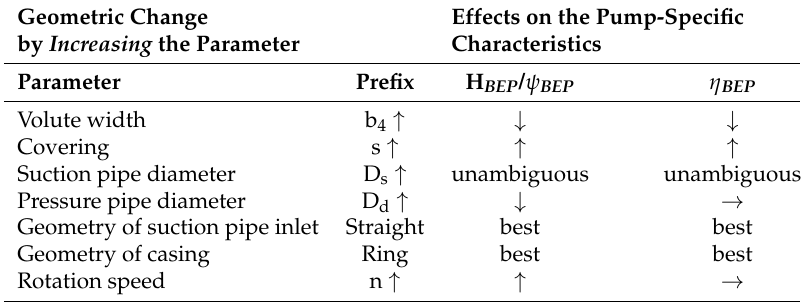
↓ ↓ ↓ ↓ ↑ ↑ ↑ Table 4. Geometric changes to the casing and changes to rotation speed and their effects on the pump-specific characteristics. Effects on the Pump-Specific by Increasing the Parameter